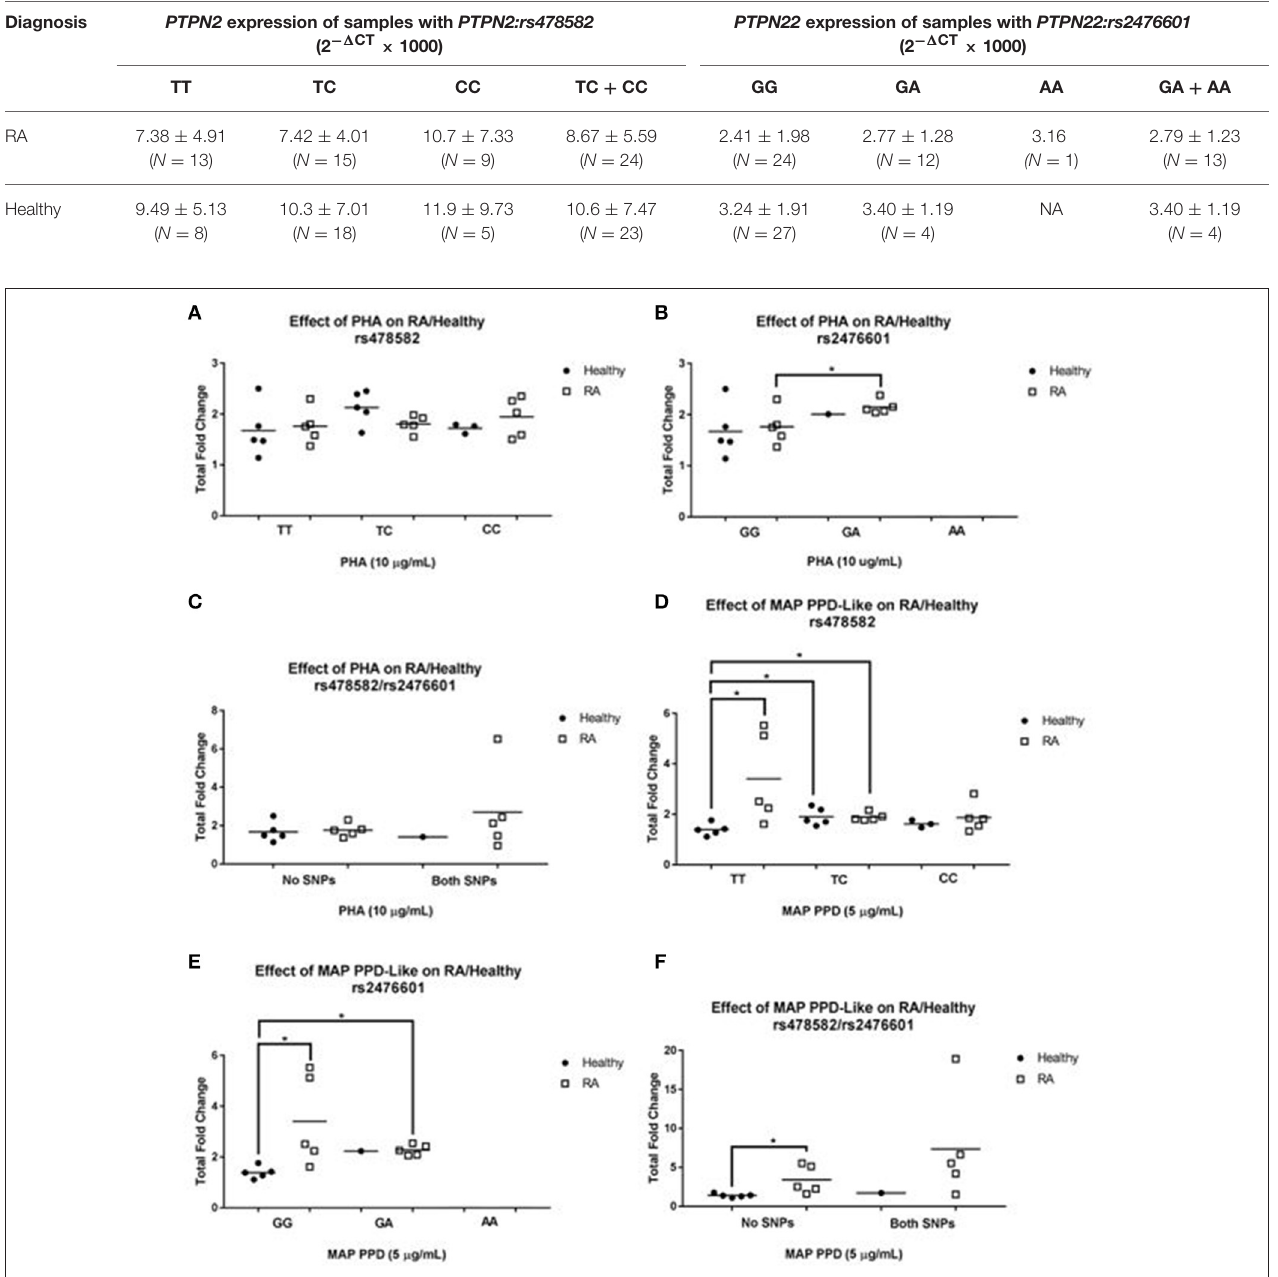
FIGURE 4 | T-cell Response in RA Associated with PTPN2:rs478582 and PTPN22:rs2476601 . (A,B) Against Phytohematoagglutonin (PHA). (D,E) Against MAP Purified Protein Derivative-Like (PPD-Like). PTPN2:rs478582- heterozygous allele (TC), minor allele (CC), and wild type (TT). PTPN22:rs2476601 -heterozygous allele (GA), minor allele (AA), and wild type (GG). The effect of combined SNPs in PTPN2/22 in T-cells induced with either PHA or MAP PPD-like is illustrated in (C,F) . * P -values ≤ 0.05.